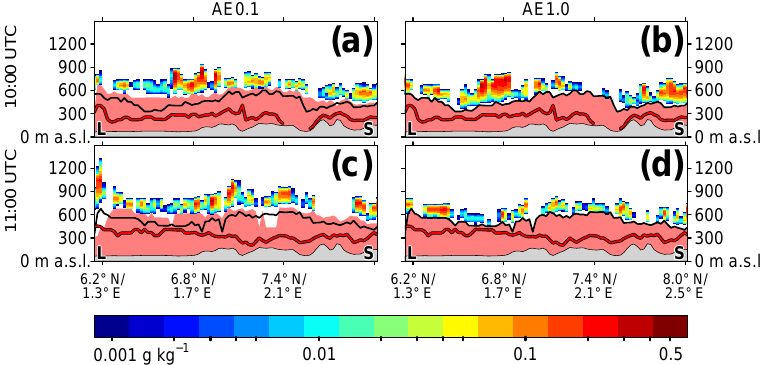
Figure 16. Cloud water (gkg − 1 , shading) along the Lomé–Savè (L and S, respectively) vertical transect (ma.s.l.) for the temporal evolution on 3 July (a, b) 10:00UTC and (c, d) 11:00UTC considering (a, c) the clean case and (b, d) the reference case. The red shading reflects instability (d θ / d z < 0) to highlight the evolution of the CBL. The black solid (red solid) line denotes the height of the CBL in the reference case (polluted case), which is simultaneously added to the panels on the left- and right-hand side.